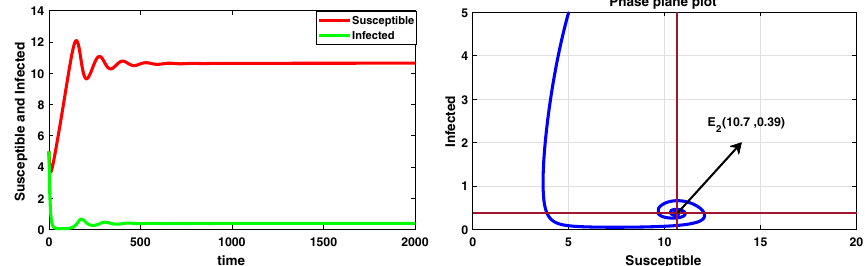
Fig. 8 A dynamical behaviour of system (4) with r > µ and the corresponding two-dimensional phase portrait of S,I with susceptible and infected isocline about endemic equilibrium point E 2 is displayed